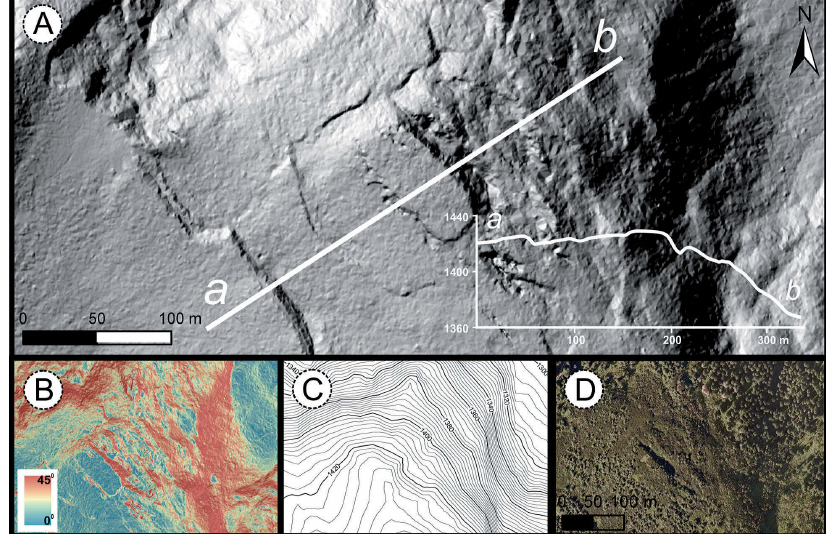
Fig. 3. Test area No 2. A – LiDAR image (a–b – topographic profile and its location), B – the map of slope reductions generat- ed from LiDAR (range of slope reductions is given), C – contour-line map, D – orthophotomap. Maps B–D at the same scale, Map A at larger